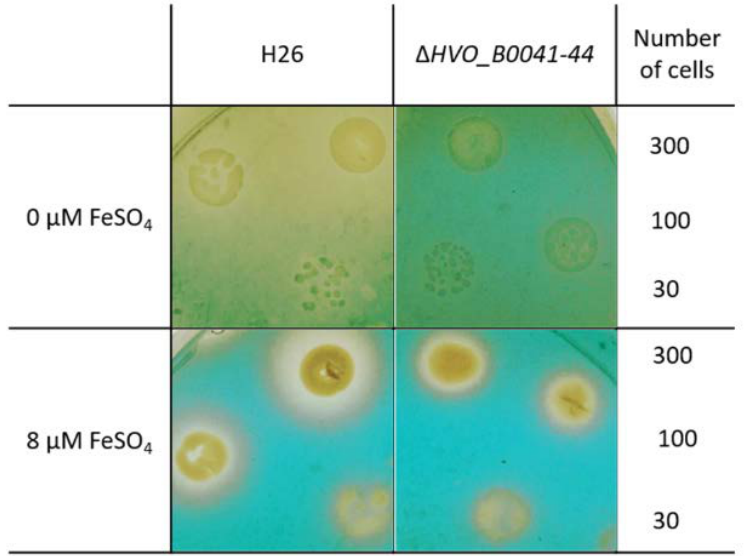
Figure 7. Overlay CAS (O-CAS) assay for the production and export of a Fe 3 + siderophore. Tenfold dilutions of the cell cultures of the wild type ( left ) and the iuc gene deletion mutant ( right ) were spotted onto agar plates. The number of cells that were spotted is indicated in the rightmost column. The plates were either devoid of iron ( top ) or contained 8 µ M iron ( bottom ). After four days of growth the plates were overlaid with a solution containing Fe 3 + and the CAS reagent. Development of a blue-green color indicated the presence of free Fe 3 + , while retention of the yellow color of the medium indicates the lack of free iron, either because it was complexed by a Fe 3 + siderophore (top left) or because it was taken up by the cells of the colonies ( bottom left).